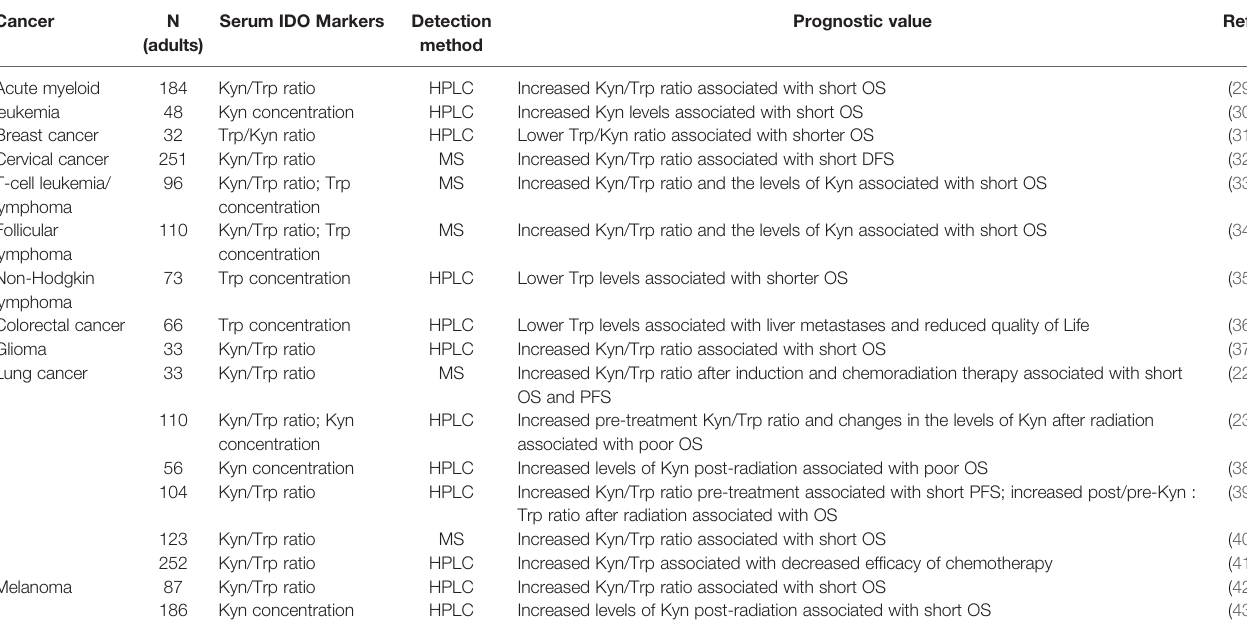
TABLE 3 | Prognostic Value of IDO Activity in Different Cancer Types. Cancer N Serum IDO (adults)